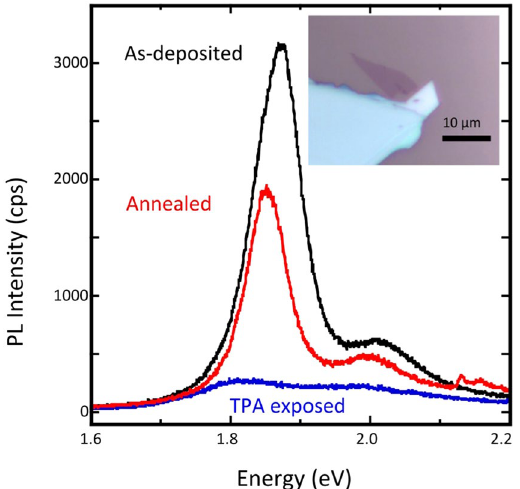
Figure 5. PL spectra of a MoS 2 film for as-deposited (black) and after 10 days of exposure to TPA (blue) and XPS performed in UHV. There was almost a full extinction in peak intensity and a ~10 meV redshift in energy, indicating a partial 2H-1T phase change. The red peak corresponds to the PL after annealing for 2 hrs. in vacuum at 450